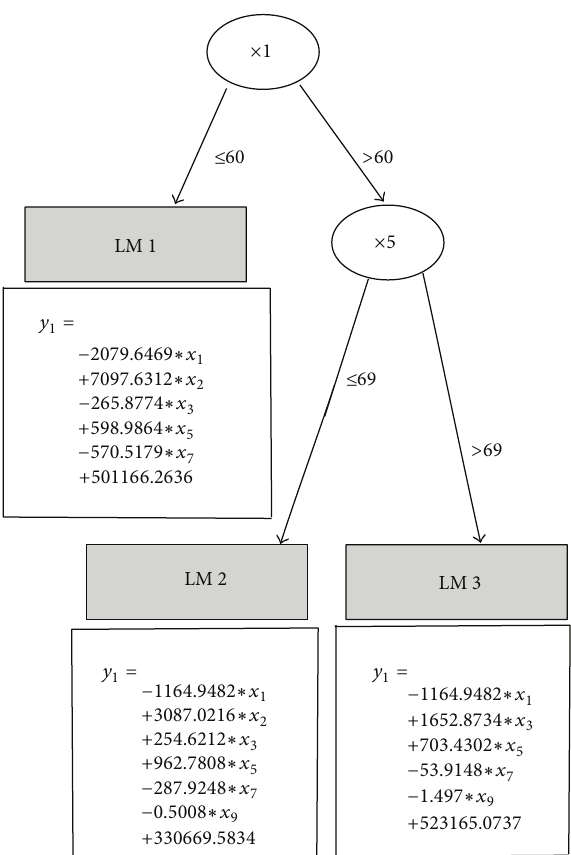
Figure 3: Model of the measured volume with a model tree.